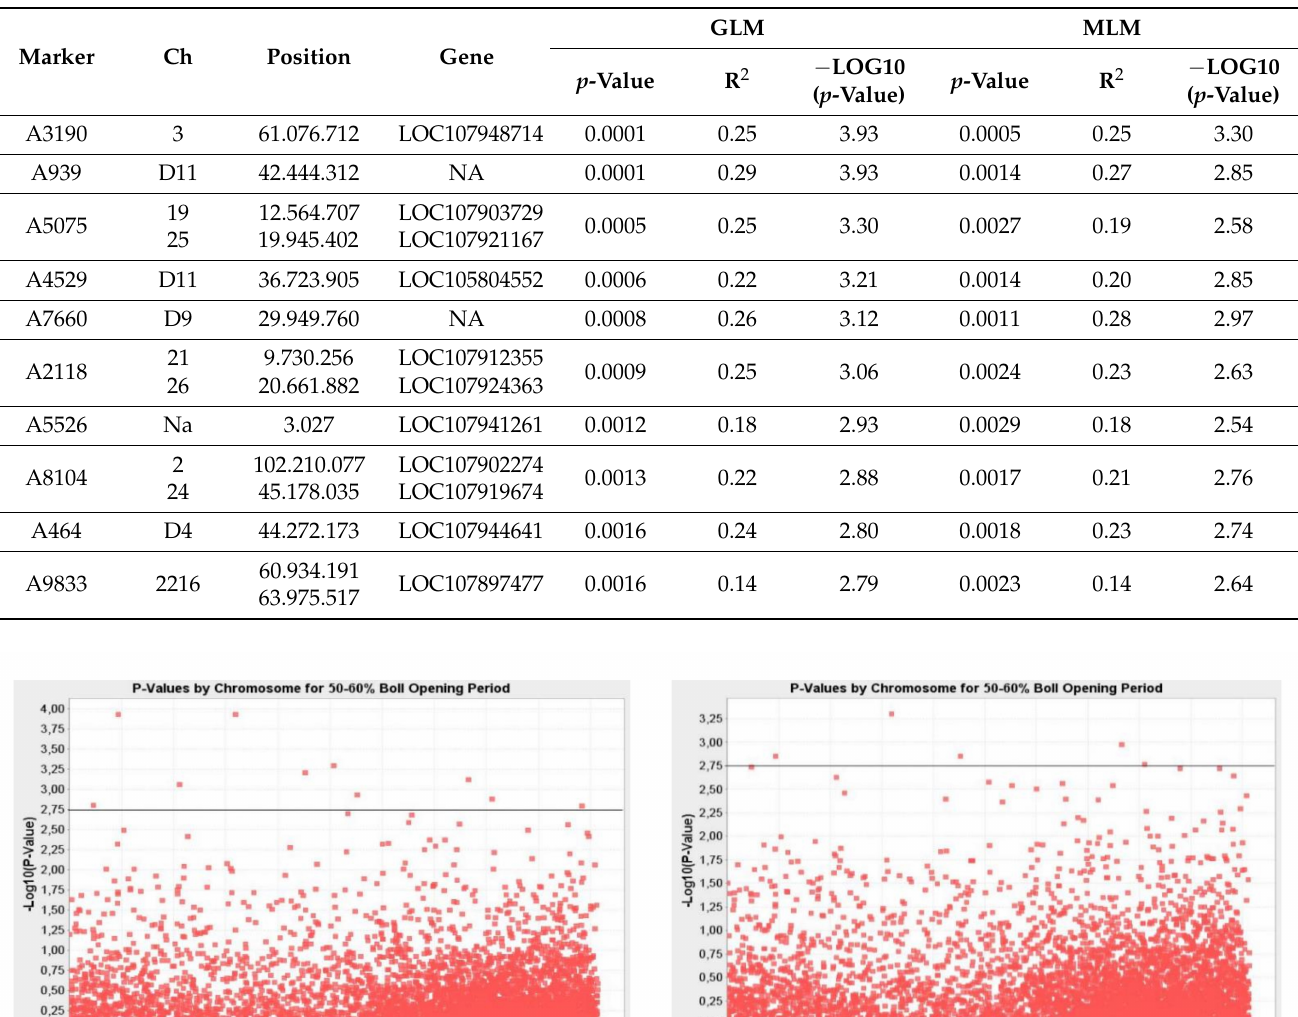
Table 1. Markers associated with resistance/tolerance to Verticillium wilt DSI on leaves at the 50–60% boll opening period.